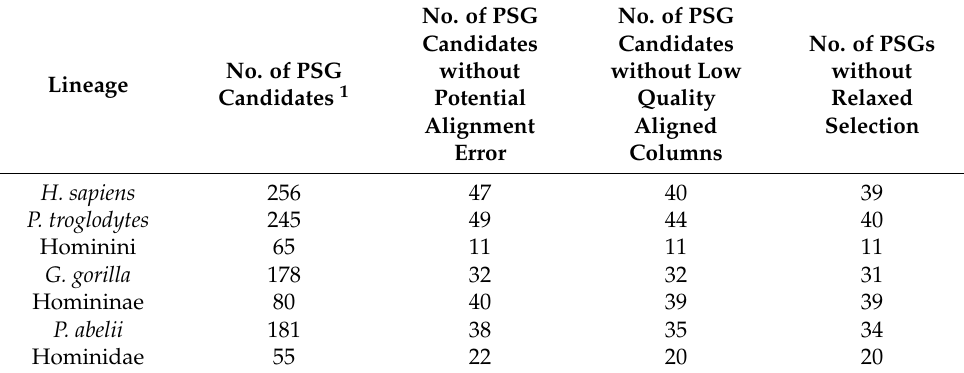
Table 2. Genetic positive selection of 14,397 one-to-one orthologs in great ape lineages. Table 3. Most of the PSGs were fixed in population.